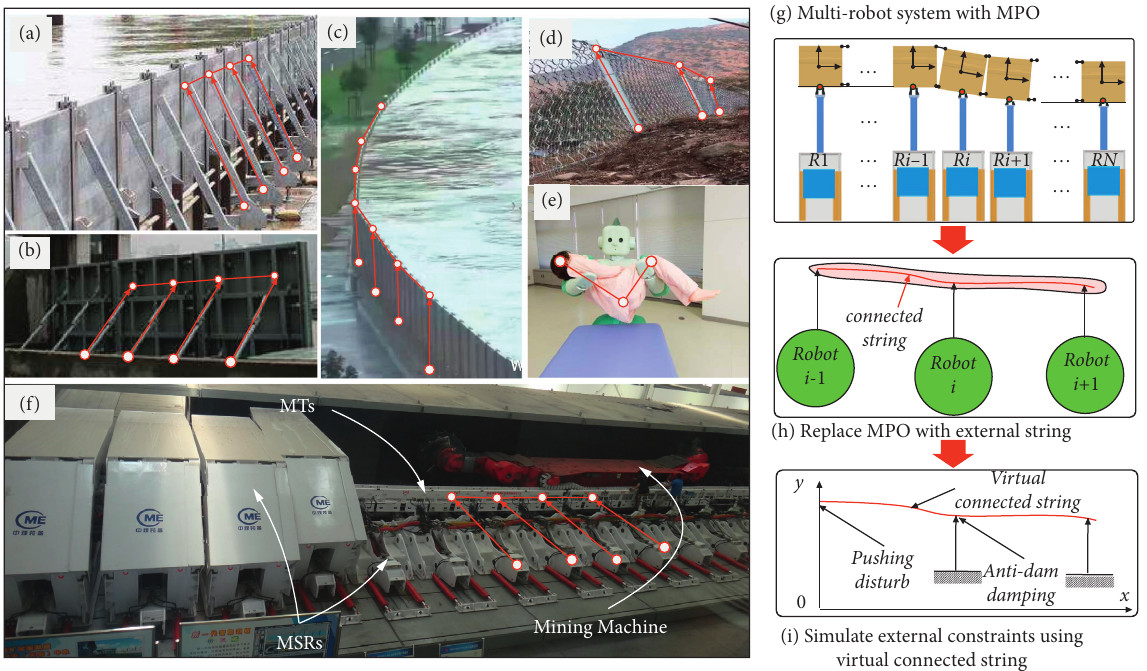
Figure 1: Widely applied scenarios of MPO. (a) Flood shield immobilized by multiple fixed oblique supports. (b) Flood shield immobilized by multiple flexible oblique supports. (c) Flood shield immobilized by multiple vertical supports. (d) Retaining wall supported by multiple bars. (e) Multiple link model-based person held by the two-arm service robot. (f) The simulated workplace of multiple MTs manipulated by MSRs on the ground. The scraper conveyor is composed of many middle troughs (MTs) and each MT is connected with other. MSRs push corresponding MT forward. (g) The diagram of the multirobot system with MPO. (h) Generalized system architecture of the multirobot system, whose manipulating object is replaced with virtual external string. (i) Simulated external constraints through virtual connected string, and both the disturbance and antidamping are